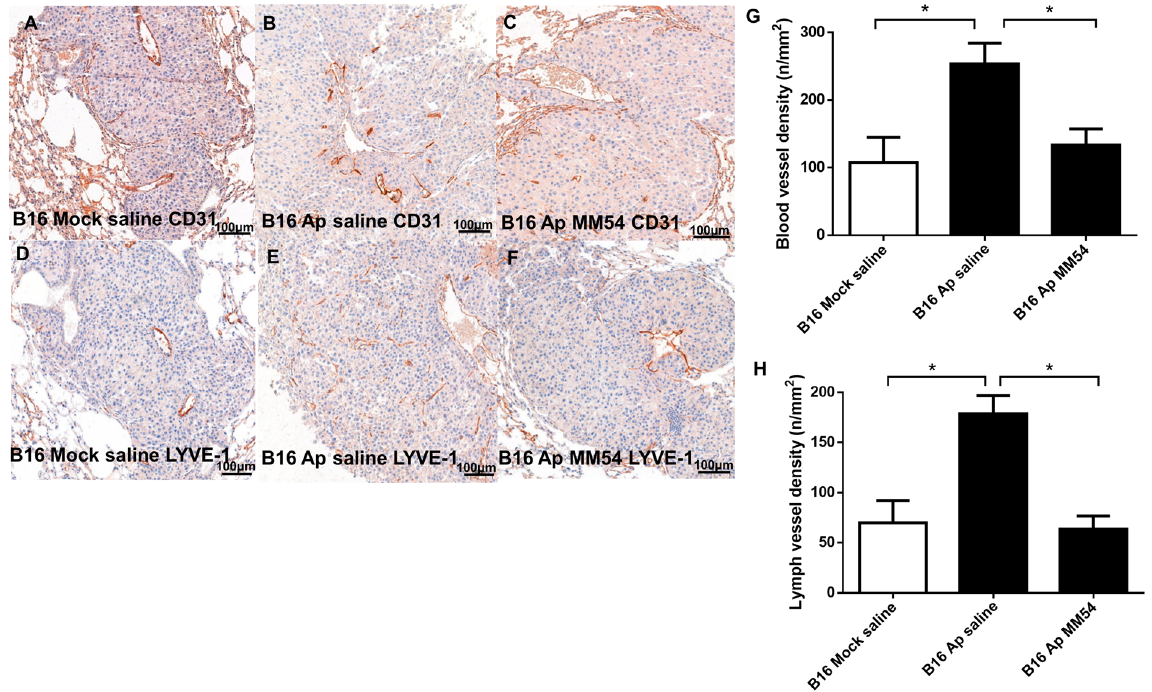
Figure 3. Apelin has (lymph)angiogenic effect in mouse pulmonary metastases, which can be attenuated by MM54. Paraffin-embedded sections of lung metastases of apelin-overexpressing B16 Ap and B16 Mock cells were stained for the blood endothelial cell marker CD31 ( A – C ) and the lymphatic endothelial cell marker LYVE-1 ( D – F ). ( G , H ) Apelin overexpression significantly increased both the blood vessel ( G ) and lymph vessel ( H ) densities. This effect was attenuated by APJ receptor antagonist MM54 ( G , H ). * p <